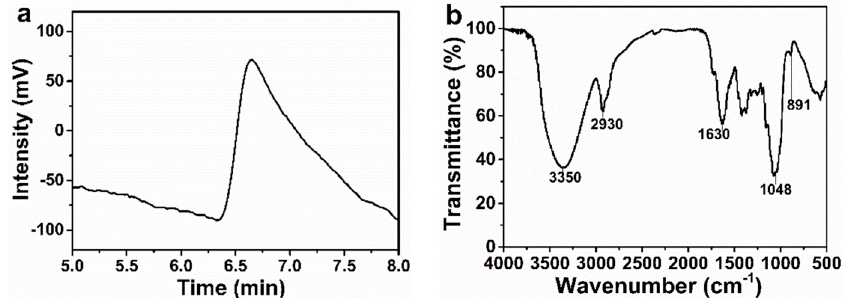
Figure 1. ( a ) GPC determination and ( b ) infrared spectrum of GLP.